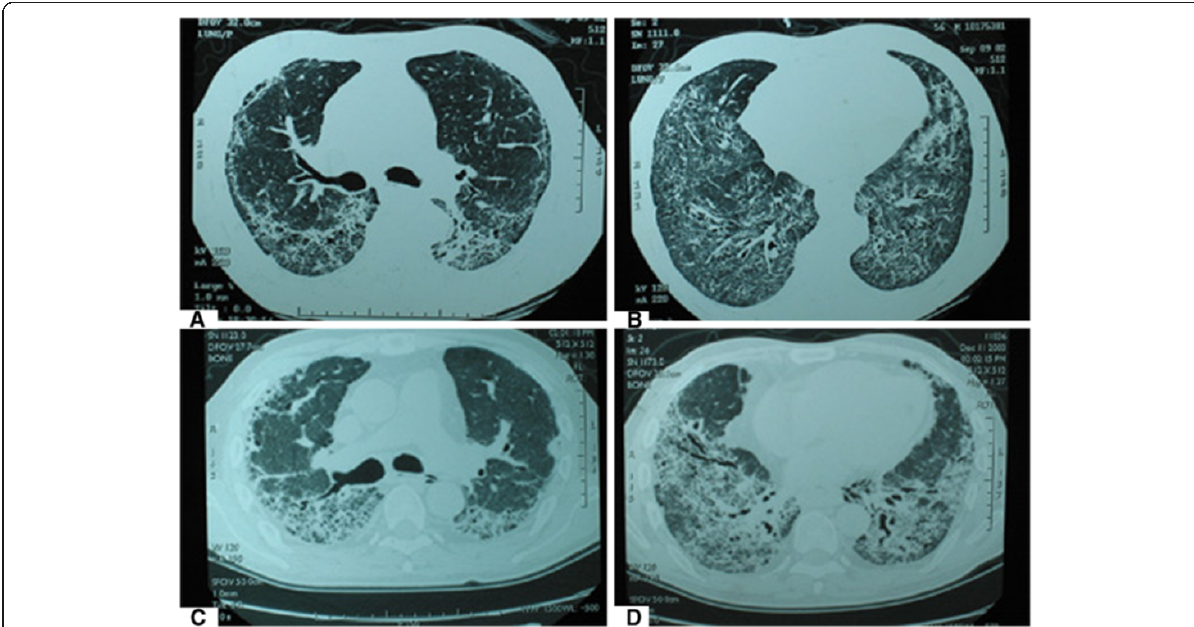
Figure 1 The examination of radiology. The chest CT displayed both lungs had reticular and ground glass opacifications, which located predominantly in subpleural and two lower lobes for two years before lung transplantation ( A , B ). To recheck CT after one year, above lesion had aggravated, showing fibrous strips with traction bronchiectasis ( C , D ).